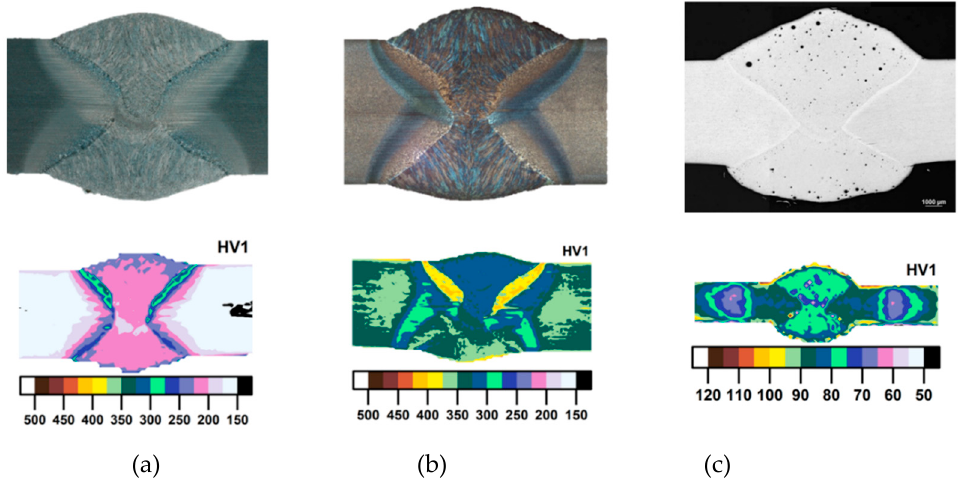
Figure 1. Macrographs of DV-butt welds. ( a ) S355N, ( b ) S960QL, ( c ) Al-6082 T6.